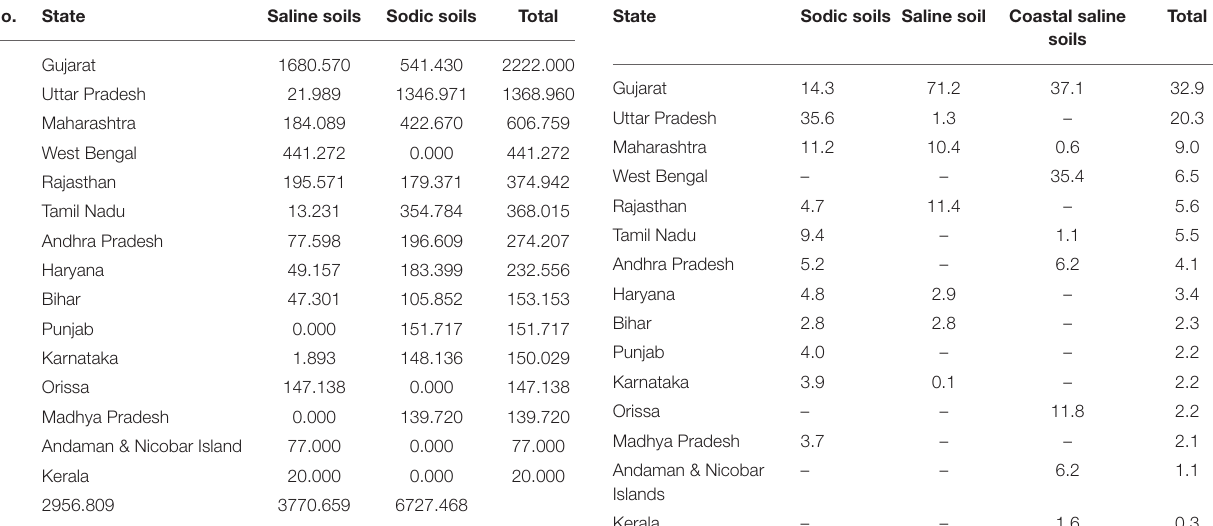
TABLE 2 | Extent of salt-affected soils in India (‘000 ha). Sr. No.